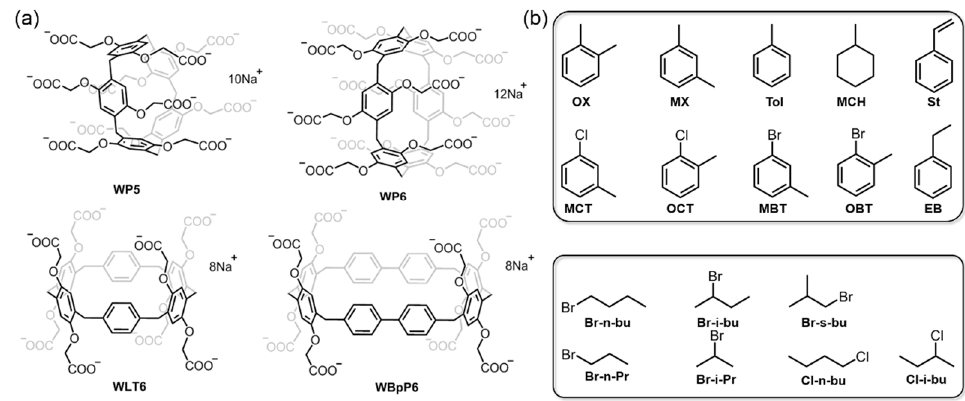
Figure 1. Chemical structures of ( a ) four water-soluble anionic macrocyclic arenes and ( b ) selected small molecule organics acting as adsorbates.